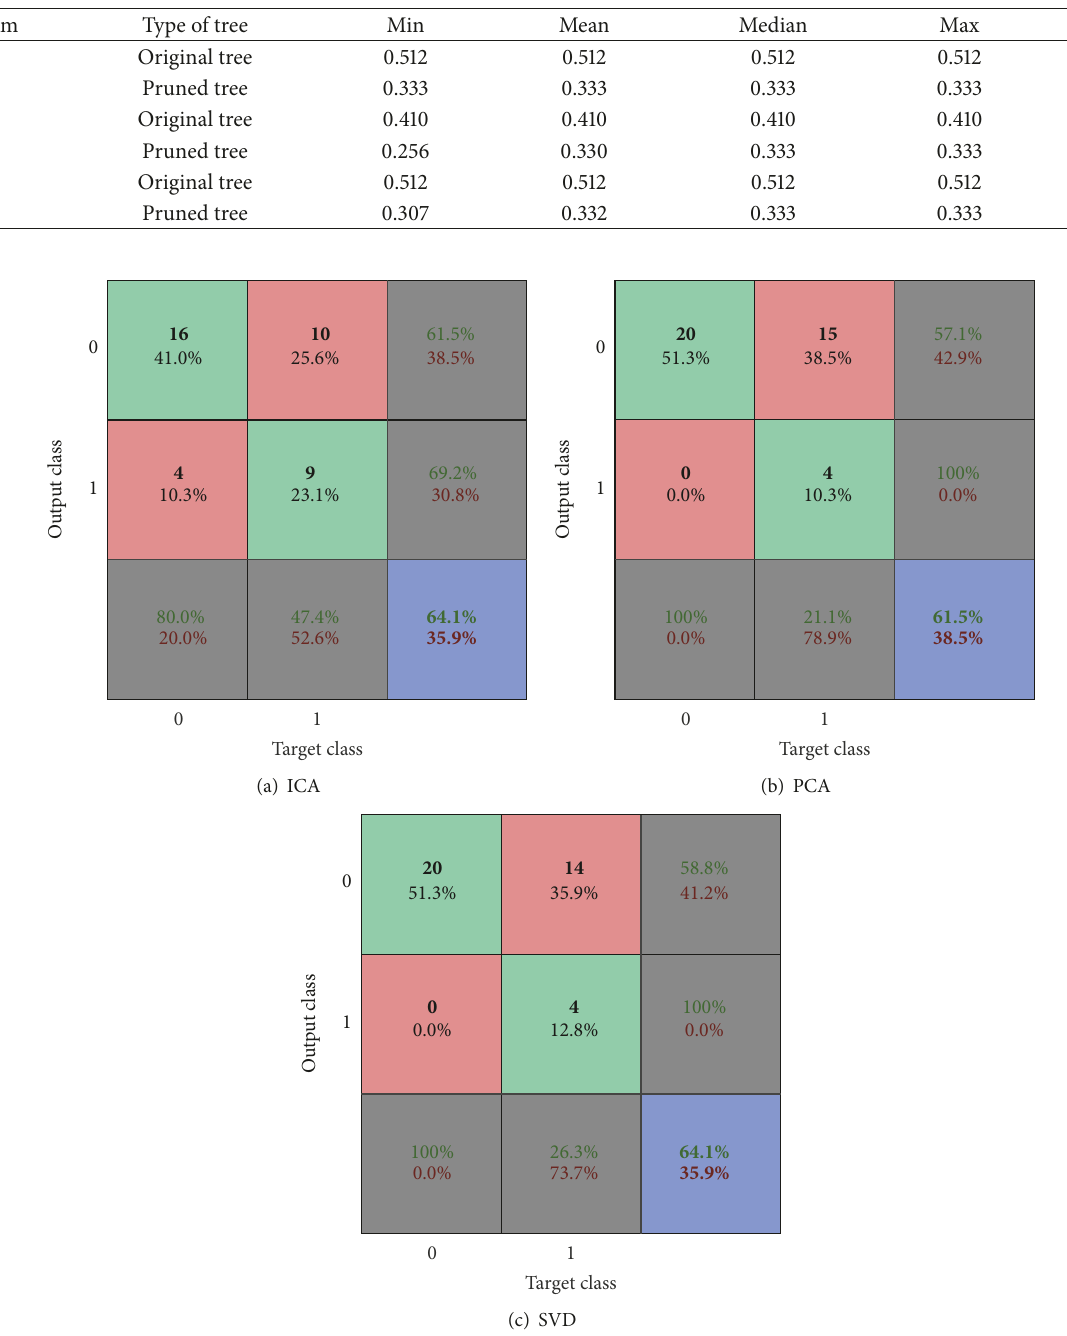
Figure 8: Confusion matrices of classification using the Gaussian Naive-Bayes for ICA, PCA, and SVD data reduction